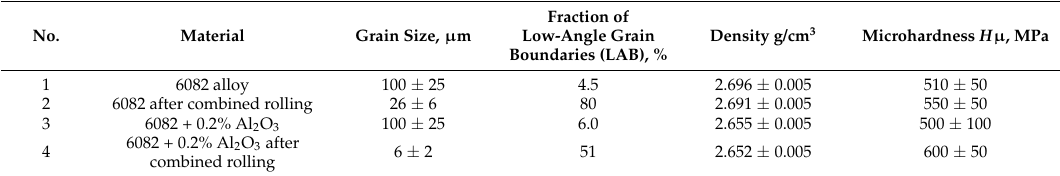
Table 1. Structure characteristics and microhardness of AA6082 alloy and AA6082-0.2 wt % Al 2 O 3 composite after casting and subsequent combined rolling.